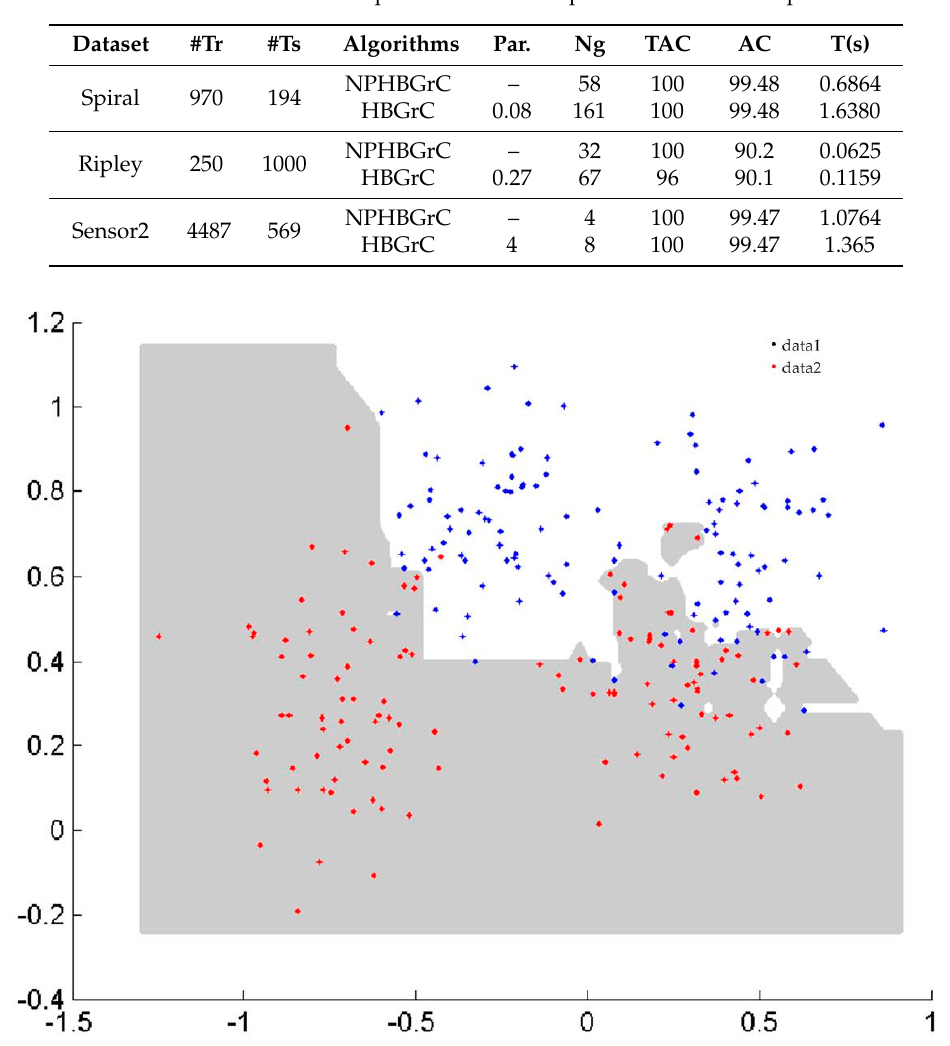
Figure 4. Boundary performed by nonparametric hyperbox granular computing classification algorithm (NPHBGrC) for the Ripley dataset.